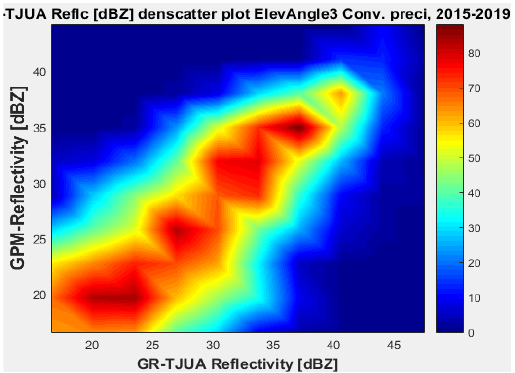
Figure 17. GPM ‐ Ka vs. NEXRAD TJUA for convective precipitation (angle 3).